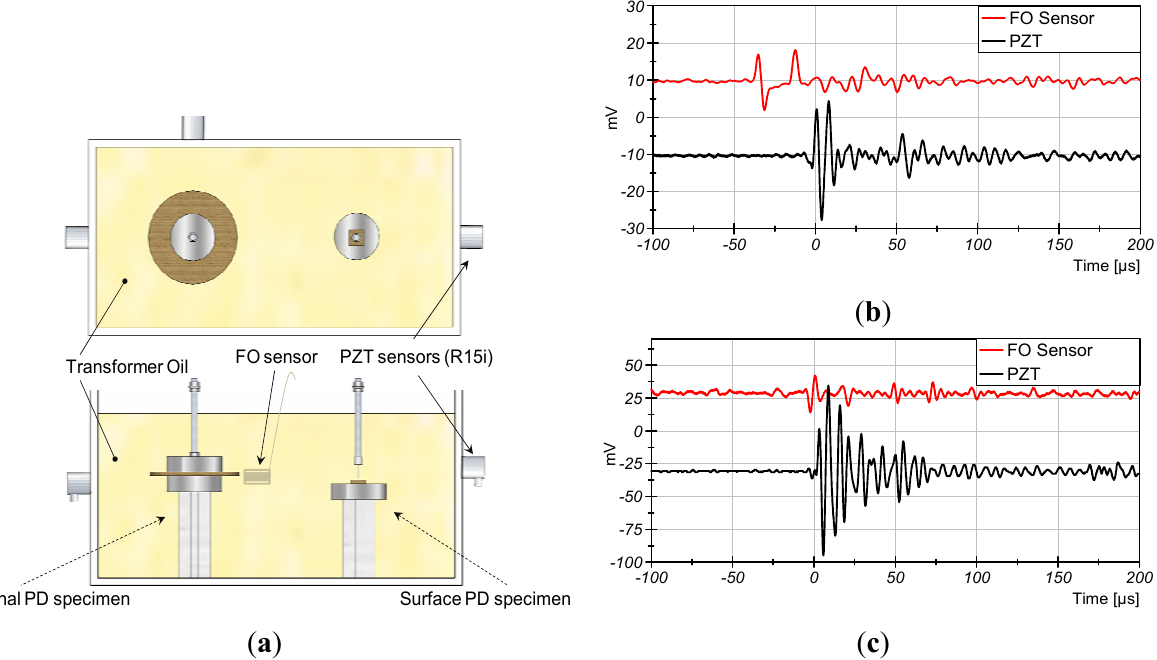
Figure 6. ( a ) High-voltage test bench of PD generation in oil; ( b ) Average of eight signals detected for internal PD; ( c ) Signals detected for surface